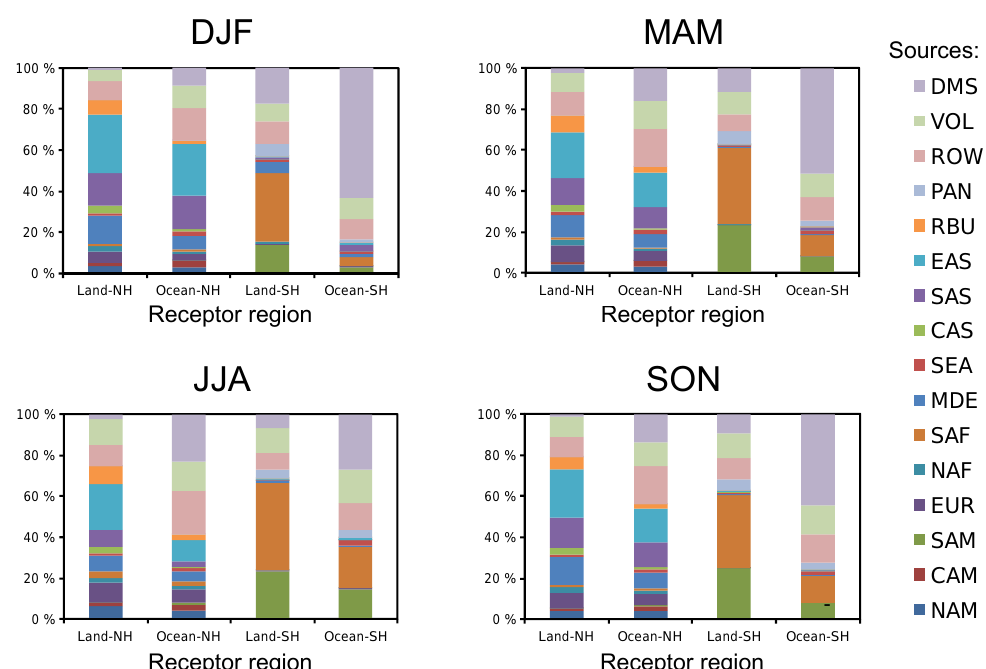
Figure 6. Relative contributions (%) to near-surface sulfate concentrations averaged over land and ocean of the Northern and Southern hemispheres from emissions in the 16 tagged source regions/sectors.